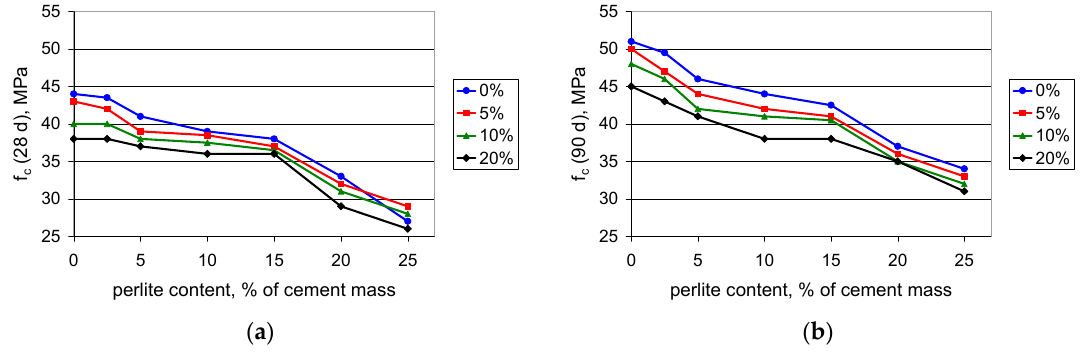
Figure 3. Compressive strength of mortars with polymer content values of 0%, 5%, 10%, and 20% of cement mass vs. waste perlite content: ( a ) after 28 days; ( b ) after 90 days of curing.